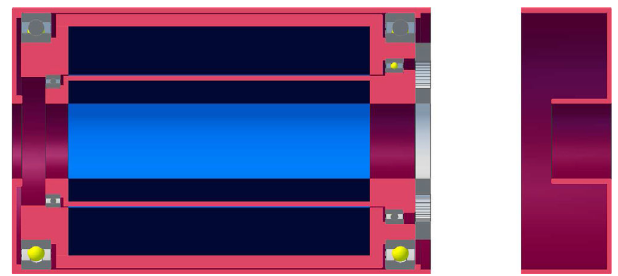
FIG. 17. Torque generated in concentric magnet design as a function of relative angle.